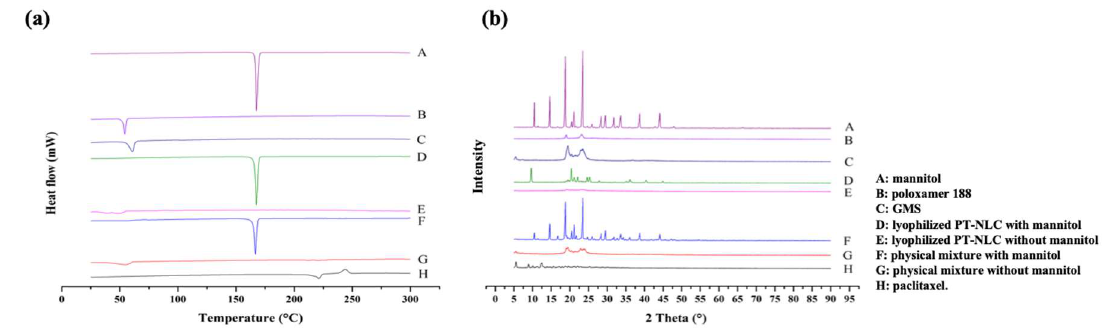
Figure 3. Differential scanning calorimetry ( a ) and powder X-ray diffraction ( b ) analysis.